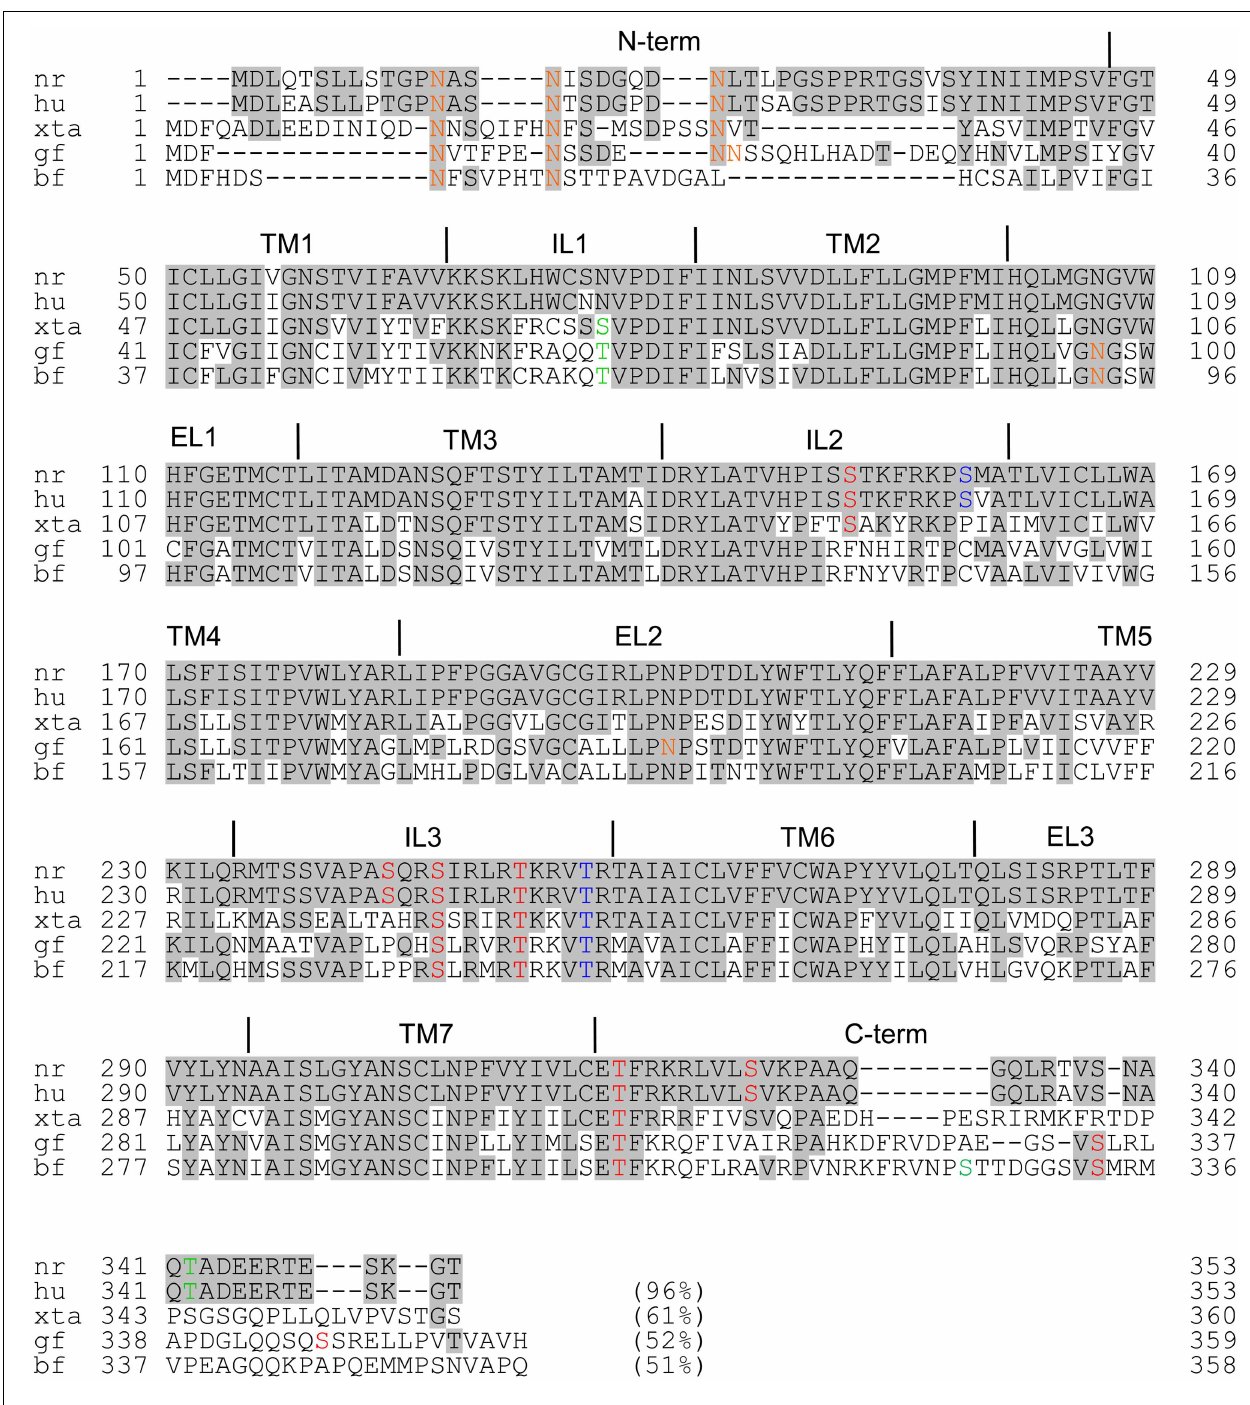
amino acids show individual motifs: orange, N-glycosylation site; green, casein kinase 2 phosphorylation site; red, protein kinase C phosphorylation site; blue, cAMP-dependent protein kinase phosphorylation site.The numbers in parentheses show the sequence identities with the rat